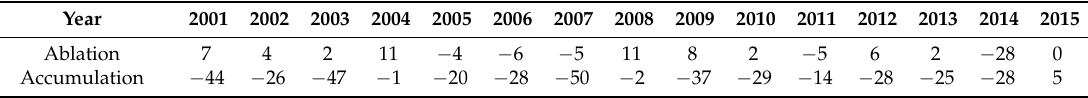
Table 9. Differences between MODIS and station data for the starting day of ablation and accumulation during